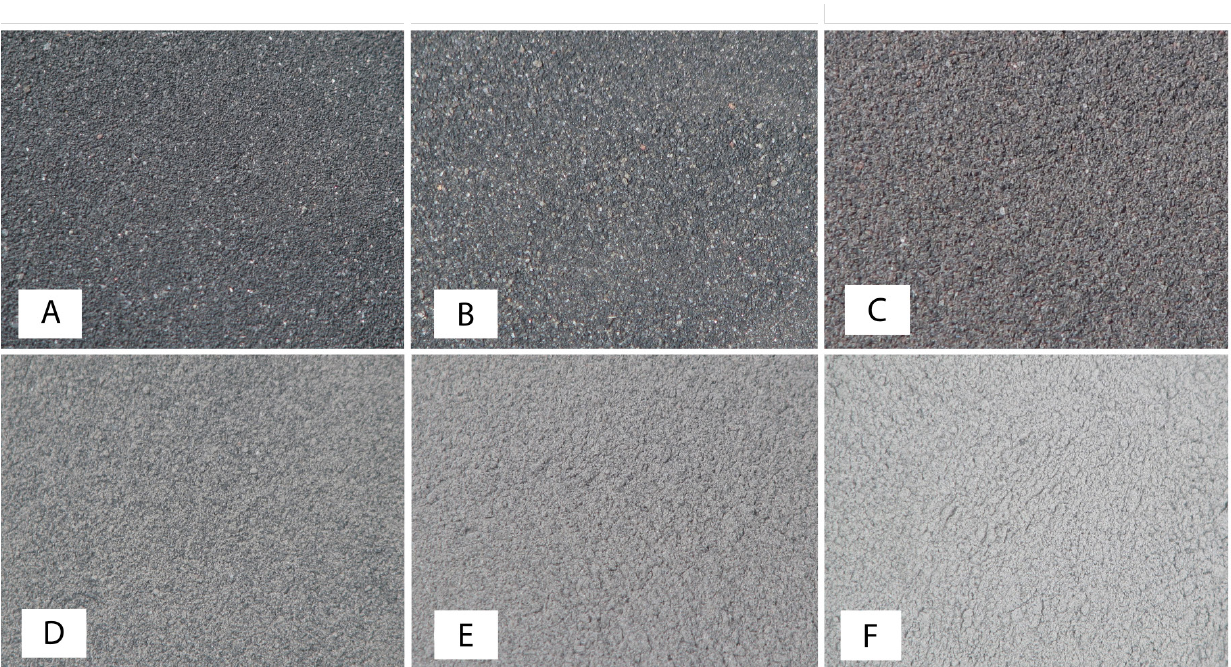
Figure 4: Photographs of six tephra materials erupted by Tungurahua volcano, each being characterised by differ- ent <63 µm -particle contents: <5 % [A]; 5 ≤ x < 10 % [B]; 10 ≤ x < 20 % [C], 20 ≤ x < 30 % [D]; 30 ≤ x < 40 % [E]; and ≤ 40 %